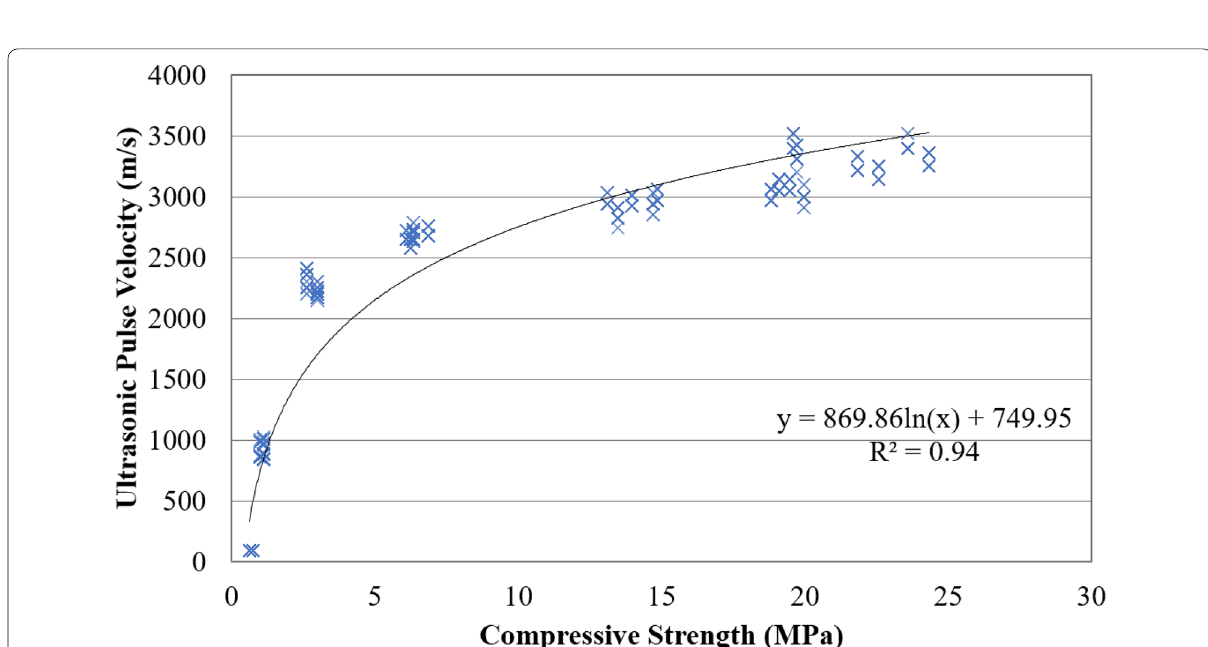
Fig. 2 Compressive strength with ages (24 MPa)